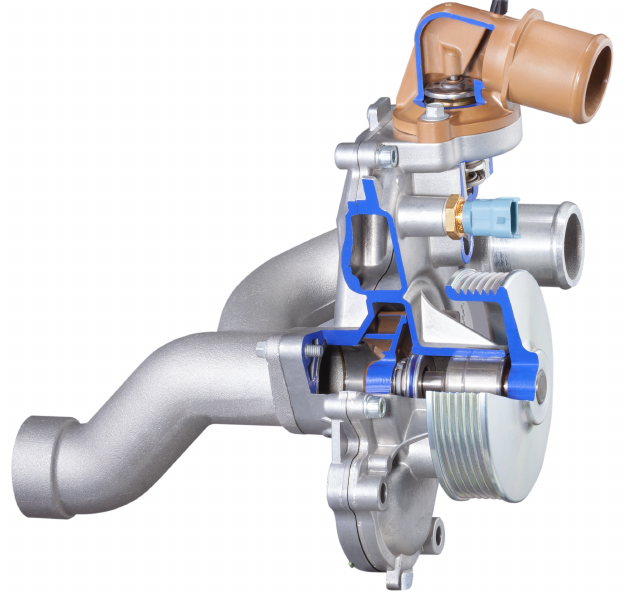
Figure 1. Centrifugal pump assembly (courtesy of Industrie Saleri Italo S.p.A.) for engine cooling circuits.